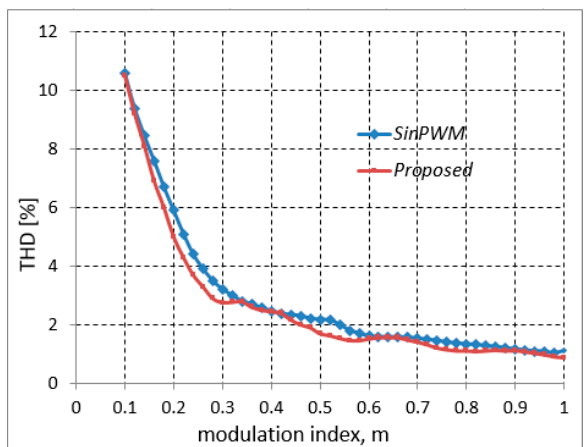
Figure 7. Total harmonic distortion (THD) comparison between sinPWM method and proposed technique at f s = 20 kHz.